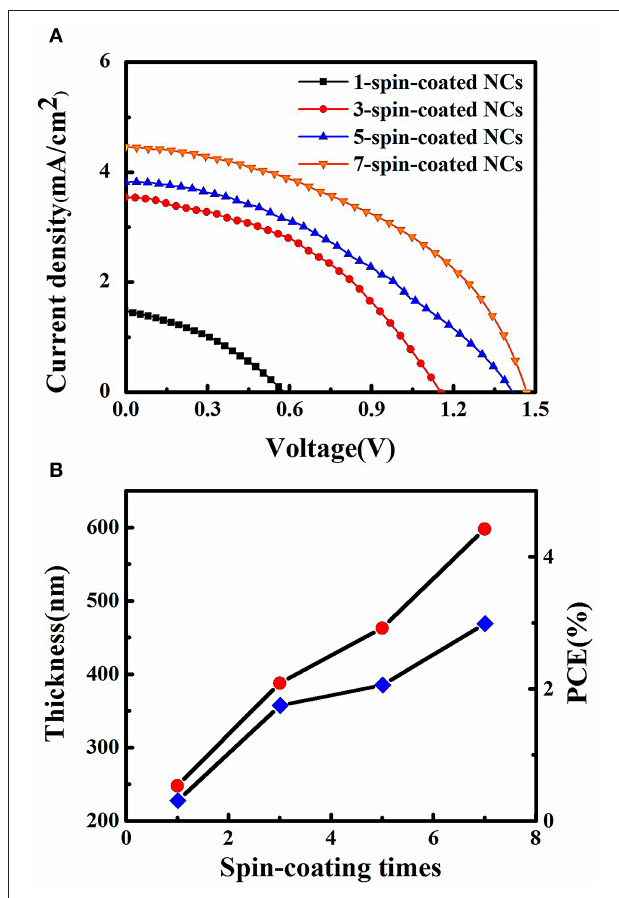
FIGURE 4 | (A) Current density-voltage curves of CsPbBr 3 NC film solar cells under AM 1.5 illumination, (B) The impact of spin-coating times on film thickness and